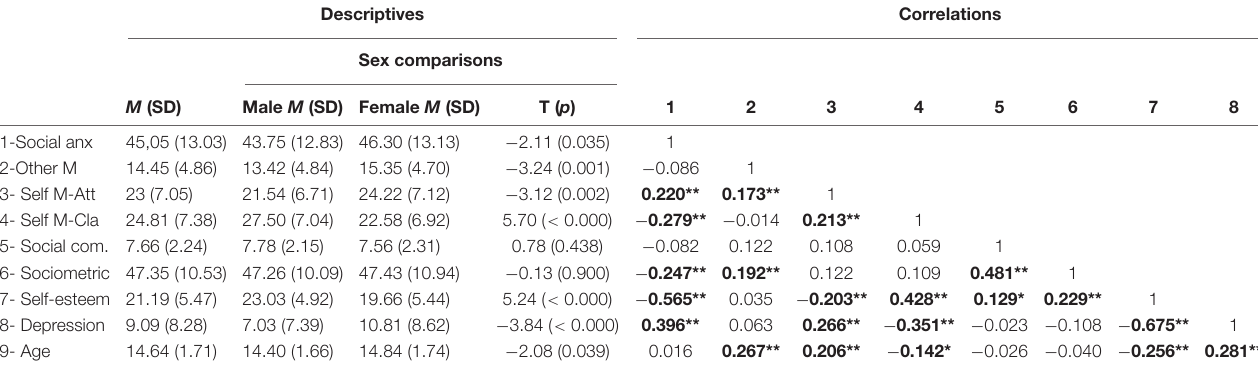
TABLE 1 | Descriptive statistics, correlations, and sex effects.